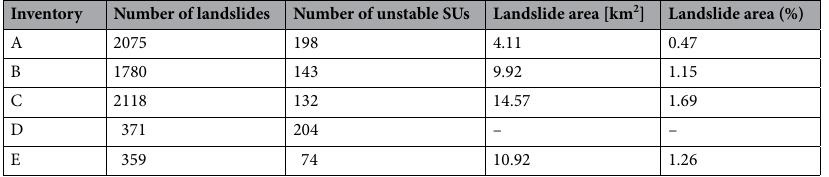
Table 1. Details of landslide inventories in an overlapping region considered in this work. Inventory D contains point locations of landslides; hence the landslide area is undefined.